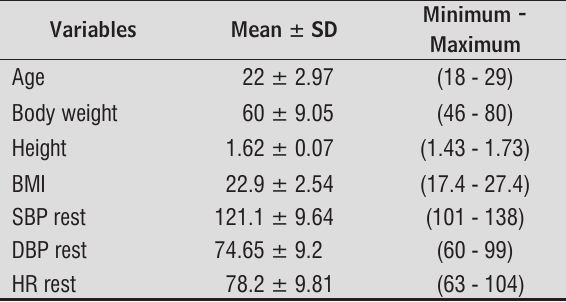
Table 1 - Demographic characteristics of the